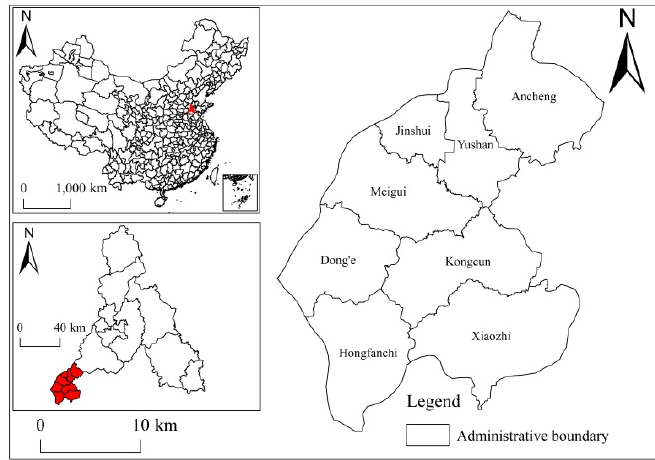
Figure 4. The administrative division of Pingyin County.